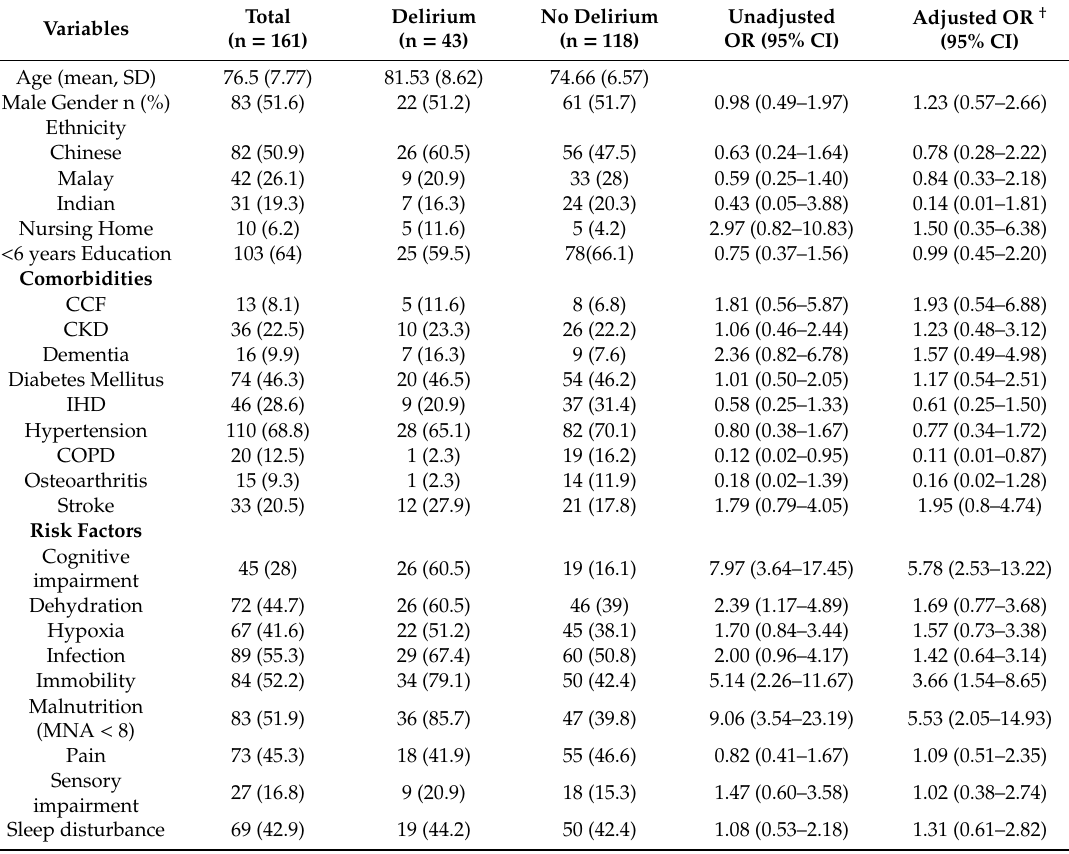
Table 1. Characteristics of patients with and without delirium.